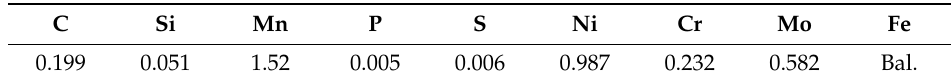
Table 1. Chemical composition of SA508